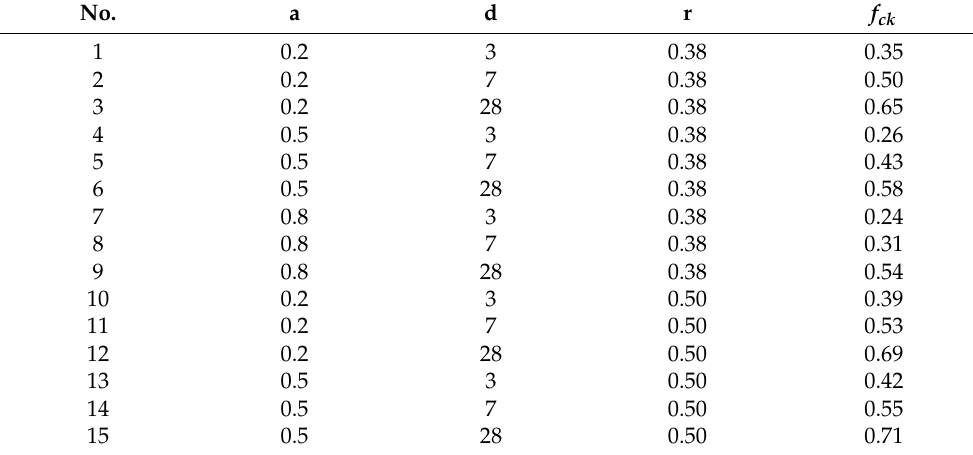
Table 3. Simulation